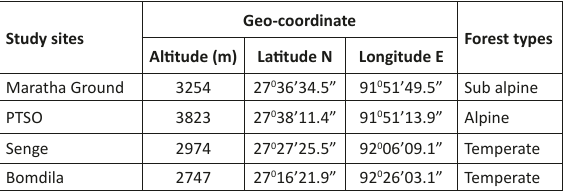
Table 1. Physiographic features and forest types of the study